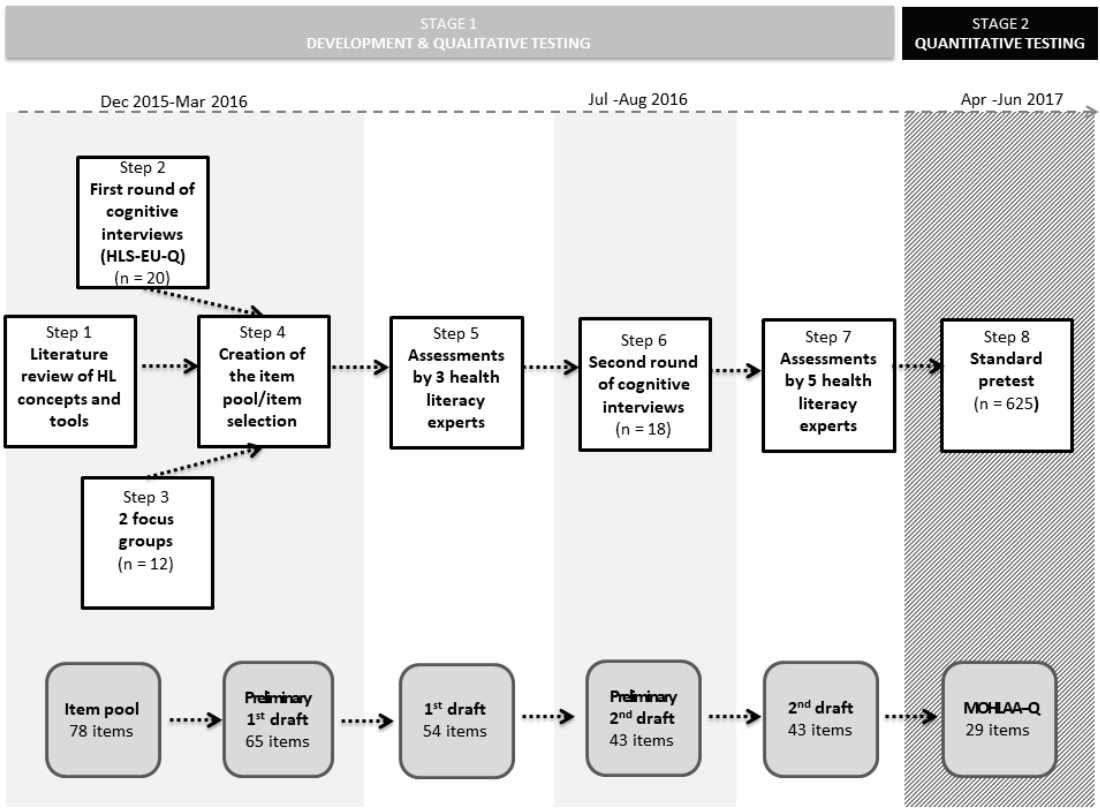
Figure 1. Phases of the development process of the MOHLAA-Q applied in the MOHLAA study (2015-2018) in Germany. (2015–2018) in